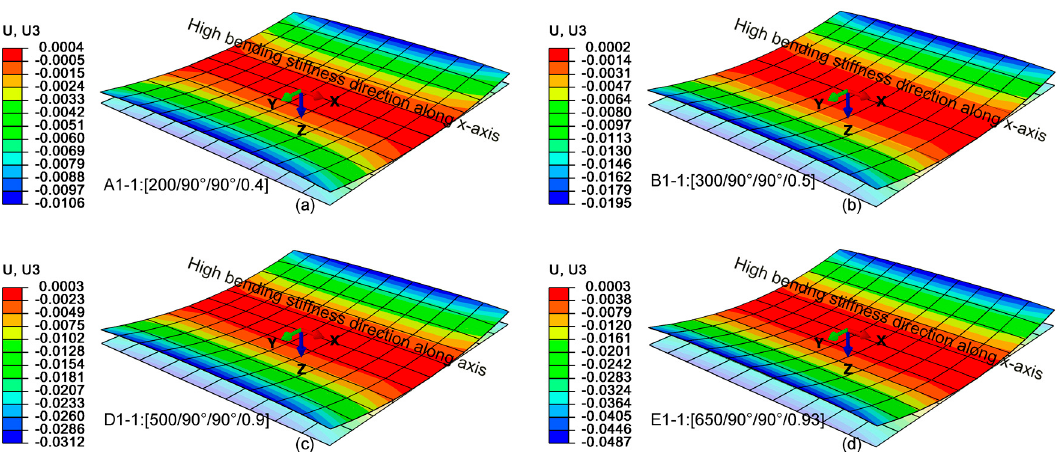
Figure 4. Cured shapes and deflections obtained at the end of the cool-down step (in meters) for sets A1-1, B1-1, D1-1, E1-1 in Table 4. Figure 5. Cured shapes and deflections obtained at the end of the cool-down step (in meters) for sets A2-1, B2-1, D2-2, E2-2 in Table 5.